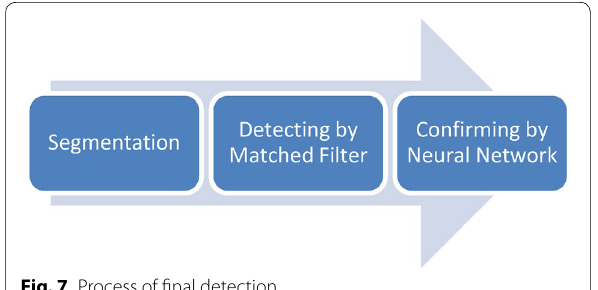
Fig. 7 Process of final detection